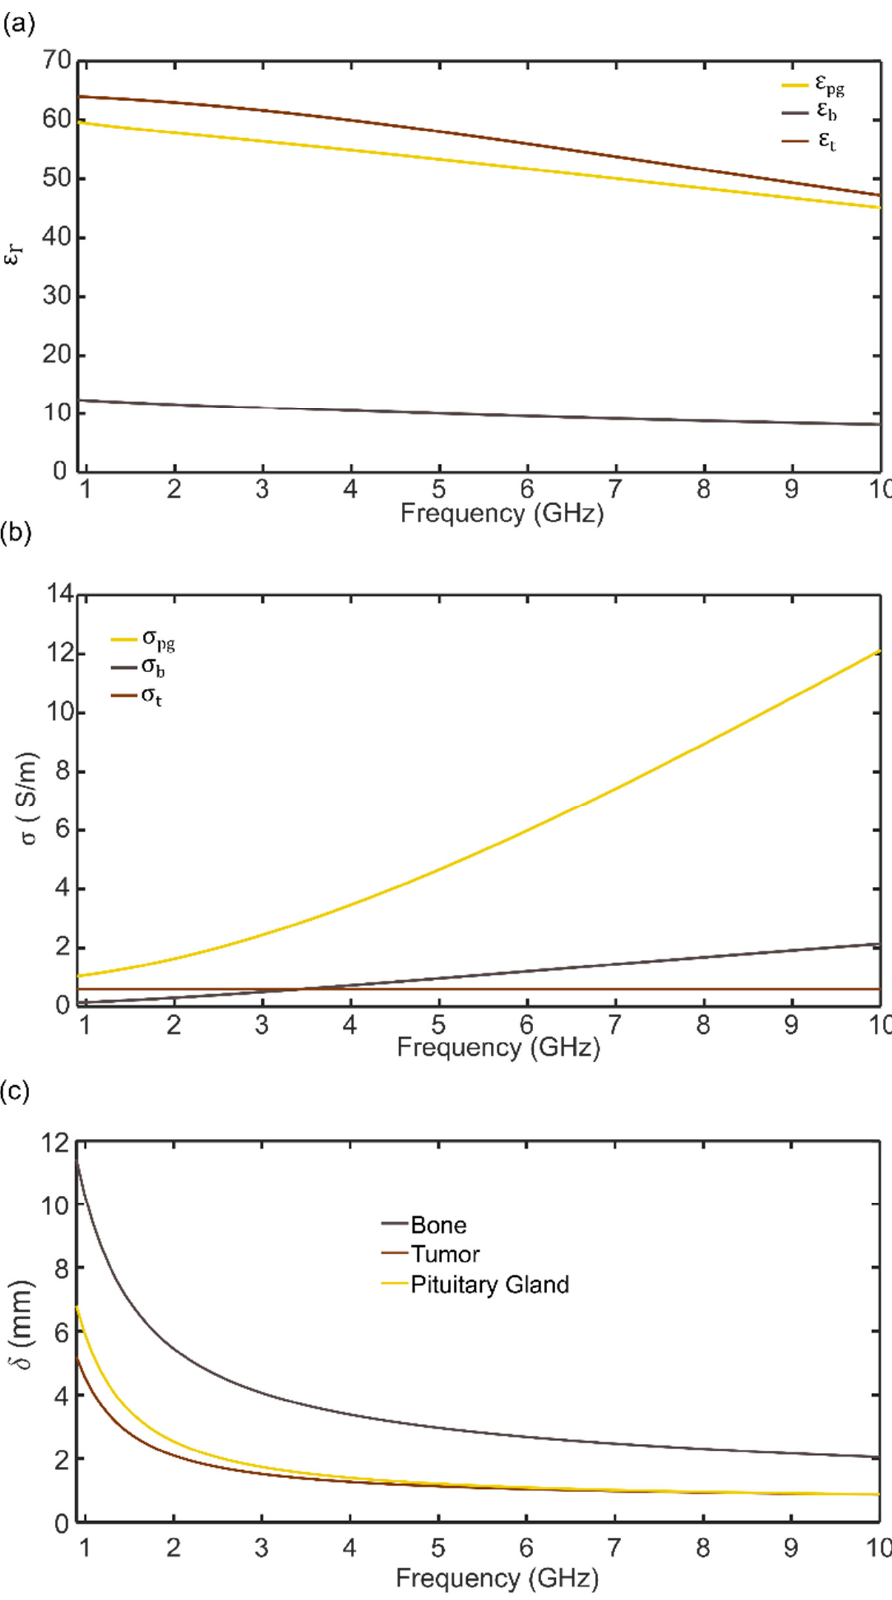
Figure 3. ( a ) Relative dielectric permittivity of the pituitary gland, bone and tumor tissues vs. frequency. ( b ) Electric conductivity (in S/m) of the pituitary gland, bone and tumor tissues vs. frequency. ( c ) Penetration depth (in mm) of the pituitary gland, bone and tumor tissues vs. frequency.